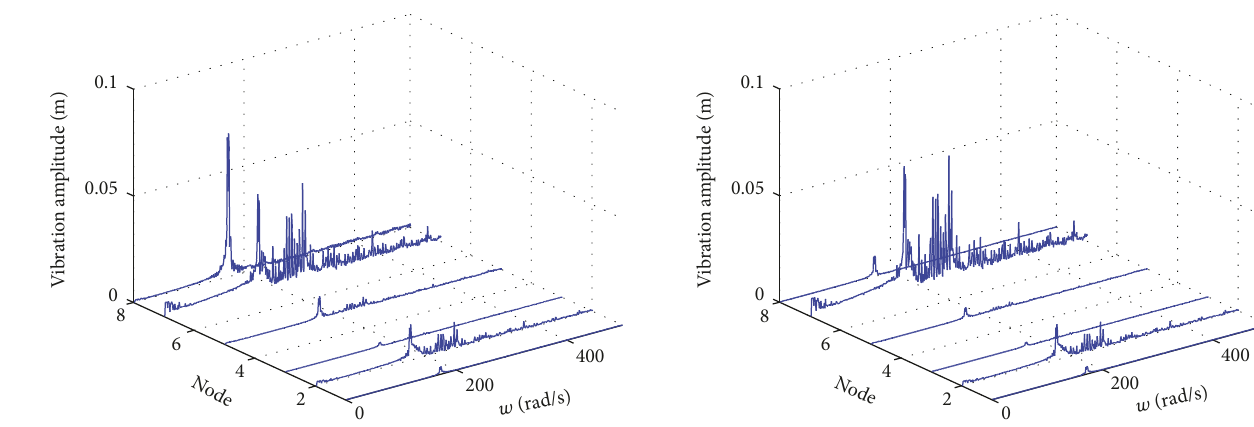
Figure 7: Nodes 5 and 8 vibrations controlled.